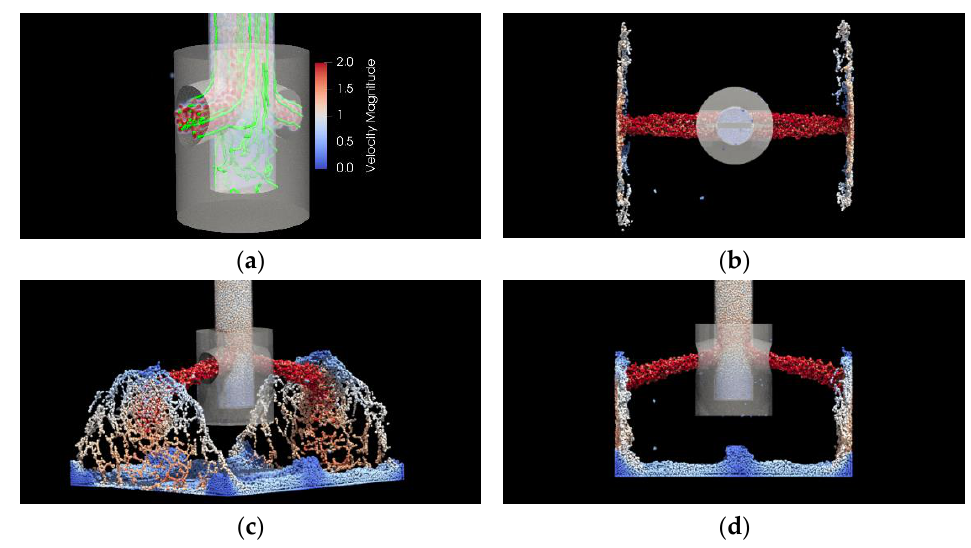
Figure 13. WBFD-20 SEN model with a pool and a flow separator. Description of each panel in the figure is the same as in Figure 10.